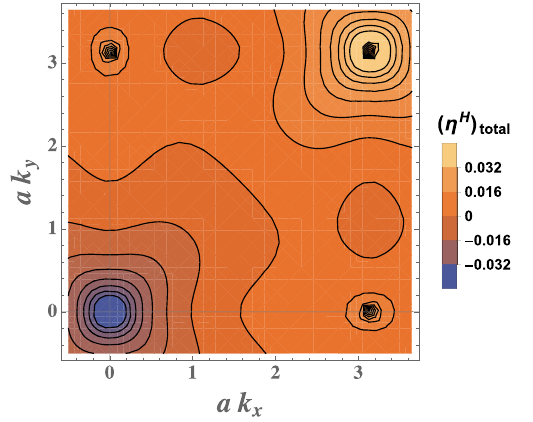
ð k Þ for the C 4 total